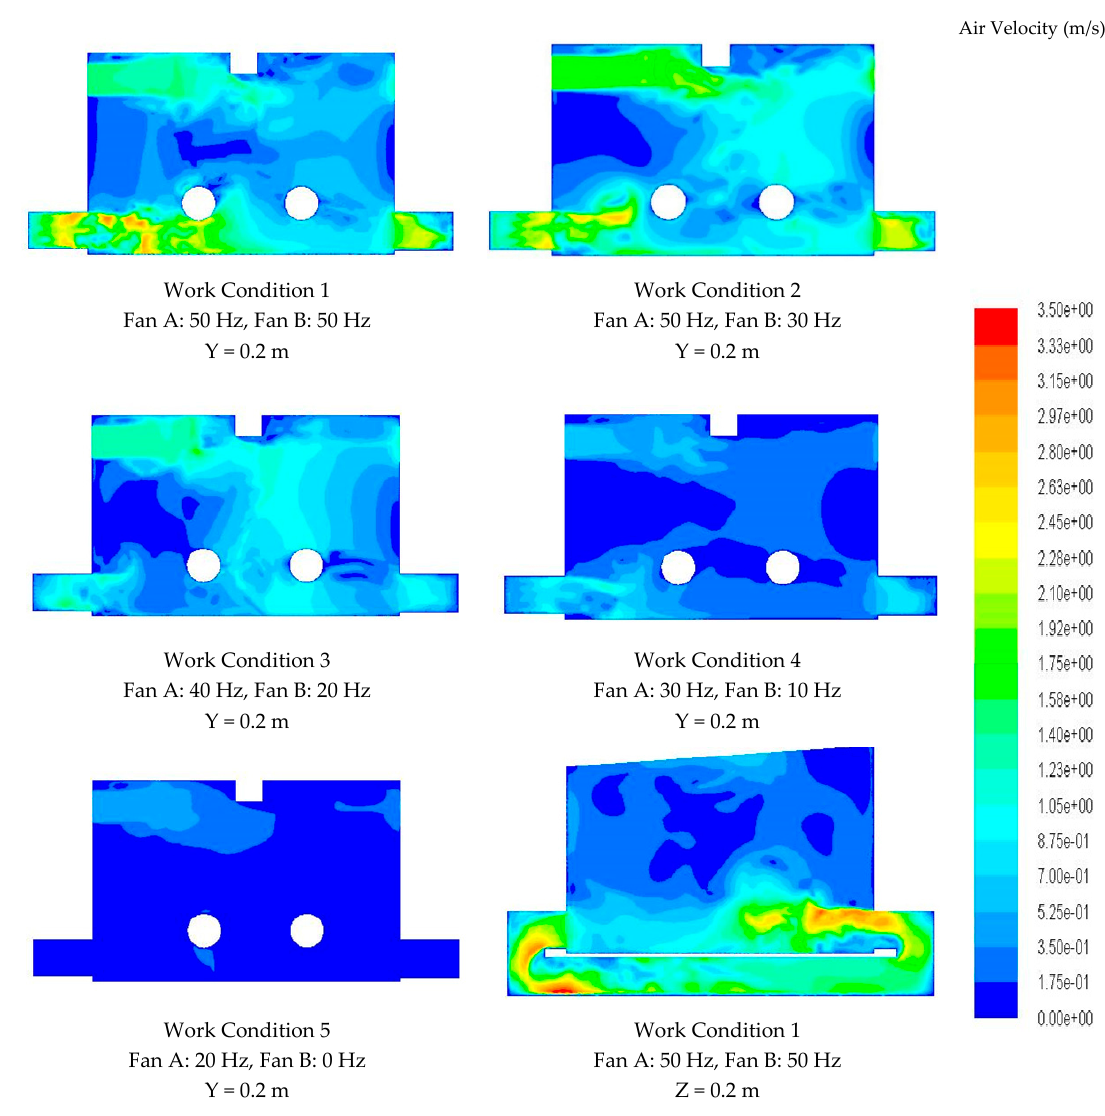
Figure 11. Simulated velocity contour of the empty chamber with the colormap on the left.